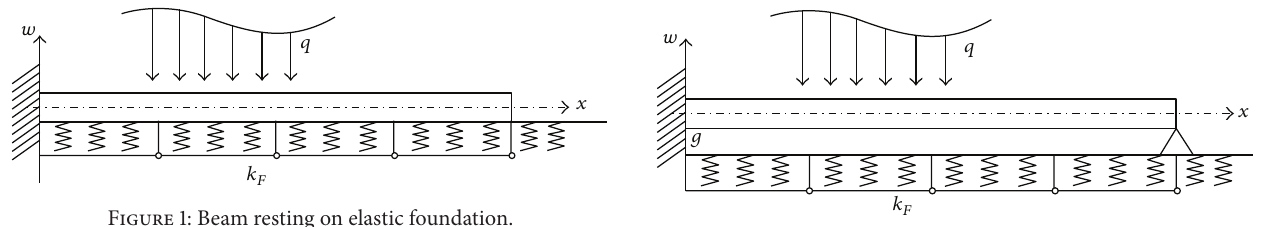
Figure 2: Beam above elastic